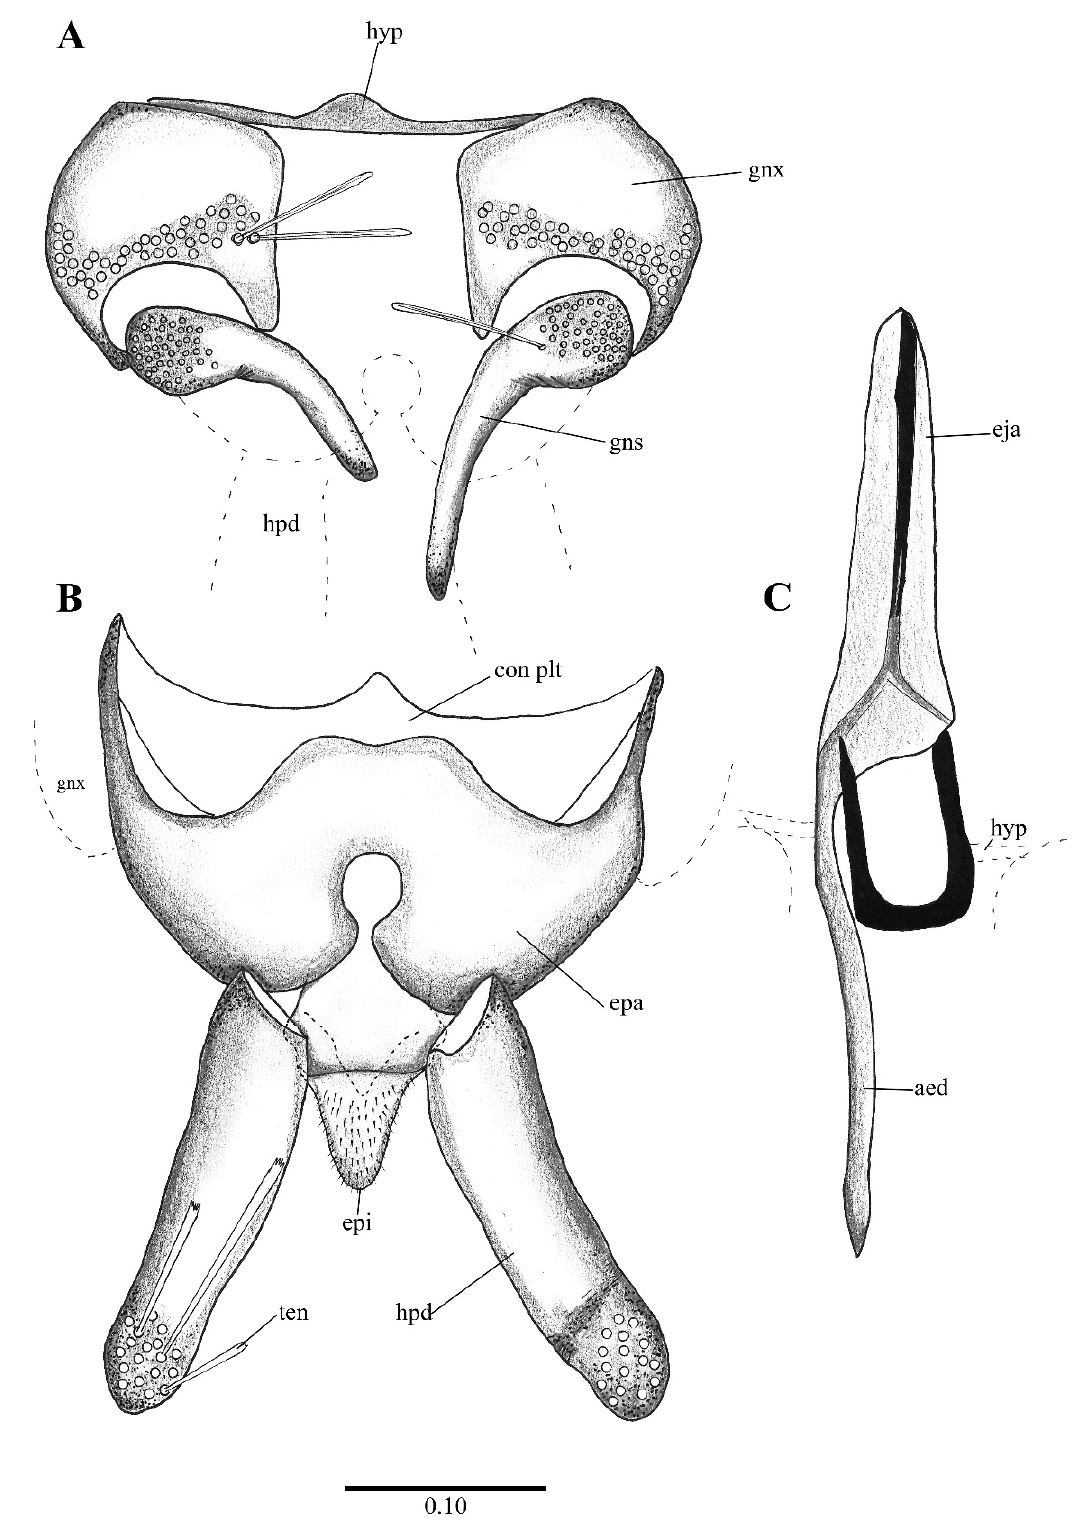
Figure 7. Lepiseodina tristis (Meigen, 1830), male genitalia. ( A ) Hypandrium, gonocoxites and gonosty- lus. ( B ) Epandrium, hypopods, tenacula, hypoproct. ( C ) Aedeagus. Abbreviations: aed = aedeagus, con plat = condyles plate-like, epa = epandrium, eja = ejaculatory apodeme, epi = epiproct, gnx = gonocoxite, gns = gonostylus, ten = tenacula, hpd = hypopods, hyp = hypandrium. Scale ( A – C ) in millimeters (mm).